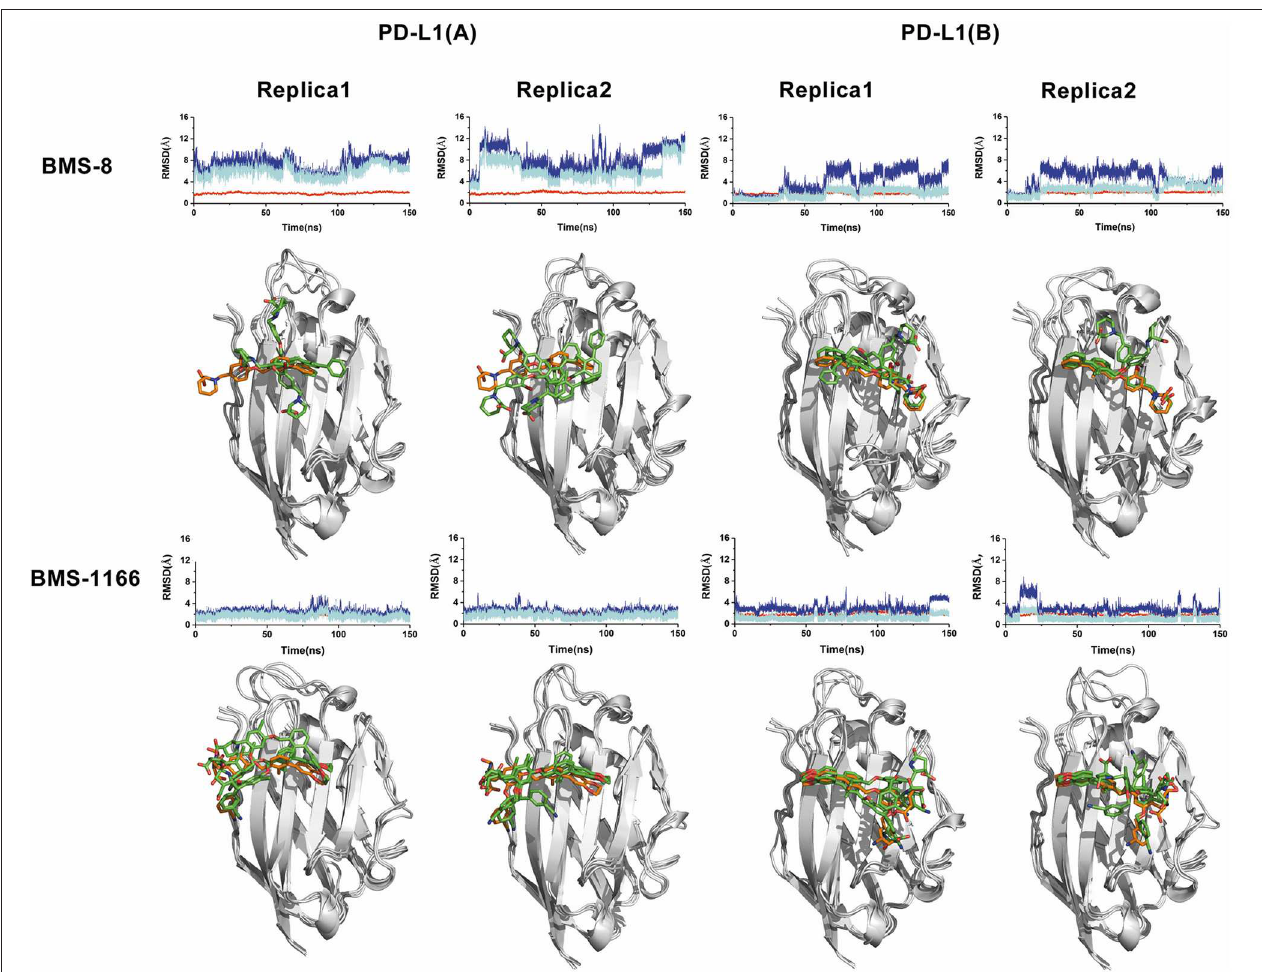
FIGURE 2 | The stability evaluation of the monomer systems. The RMSDs of the heavy atoms of PD-L1 monomer, ligands (BMS-8, BMS-1166) and the core scaffold of the ligand are shown in red, blue, and cyan lines, respectively. The representative conformations of three clusters for every monomer system was shown below the corresponding system. PD-L1 is shown in gray cartoon while the initial conformation of ligand is shown in orange sticks and the dynamics conformations of ligand is shown in green sticks.